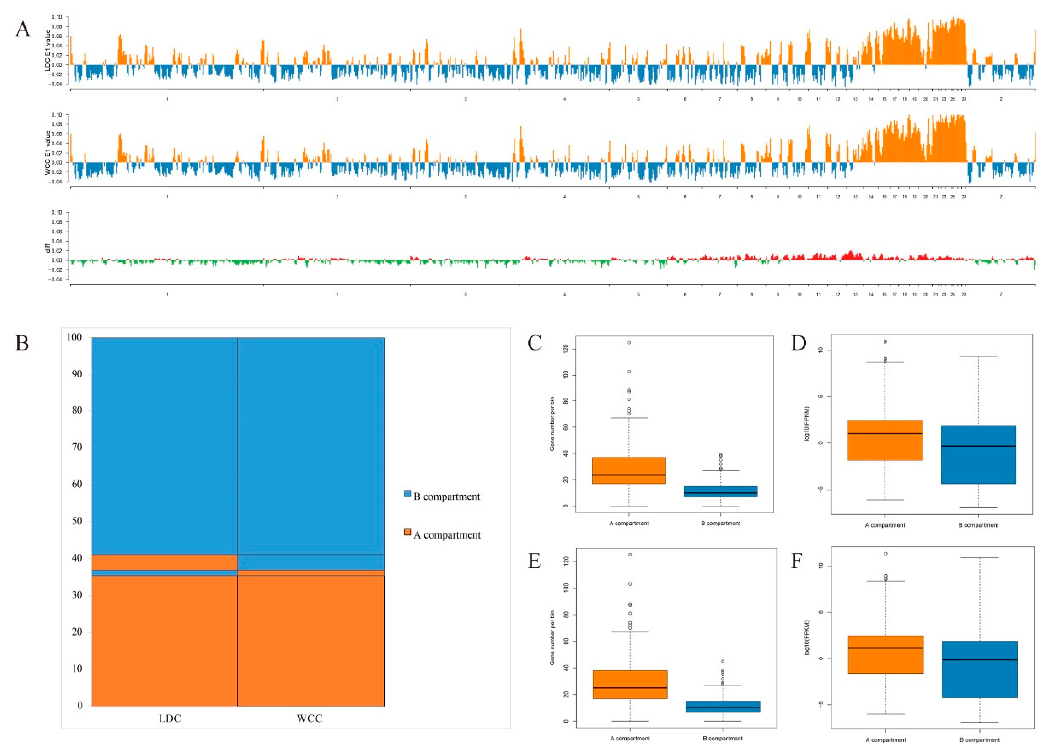
Figure 2. Association between A/B compartment switches and gene expression. ( A ) Distribution of the A/B compartments in the whole genome of two liver cells. A compartments are shown in orange, B compartments are shown in blue. The diff means the absolute difference between the PC1 value of two Hi-C data, and the value greater than 0 are shown in red, less than 0 are shown in green. ( B ) Genome-wide proportions of A/B compartment changes in the whole genome of two liver cells. Gene numbers ( C , E ) and expression ( D , F ) volume map of A/B compartments in the whole genome of LDC and WCC liver cells.